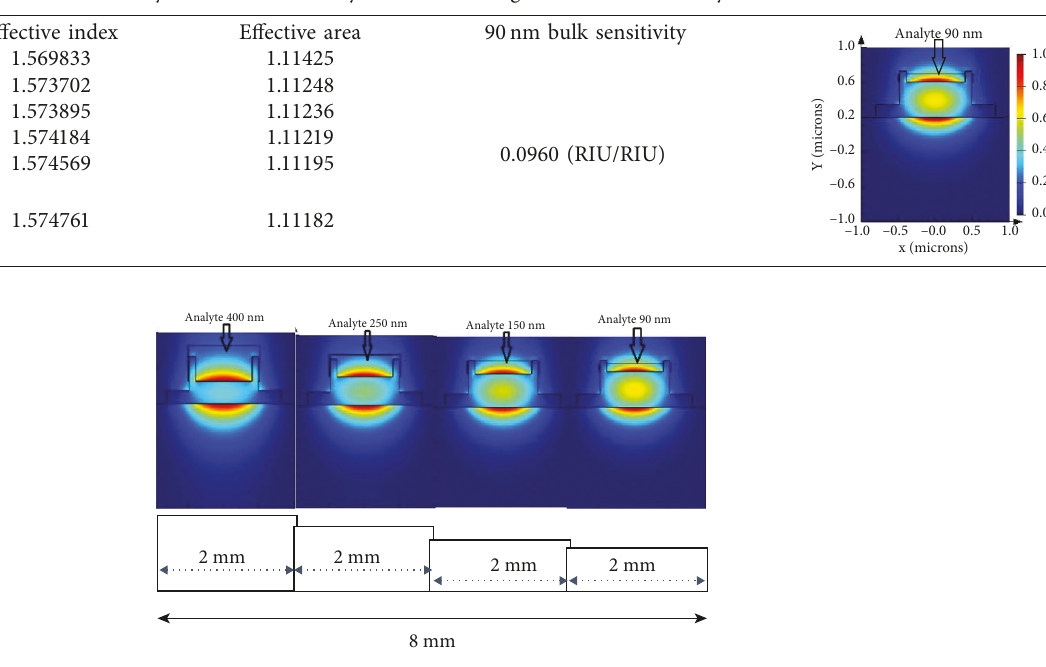
Figure 5: Gradient rib-slot waveguide structure with a width of 450nm and height of 220nm with integrated analyte thickness of 400nm, 250nm, 150nm, and 90nm.